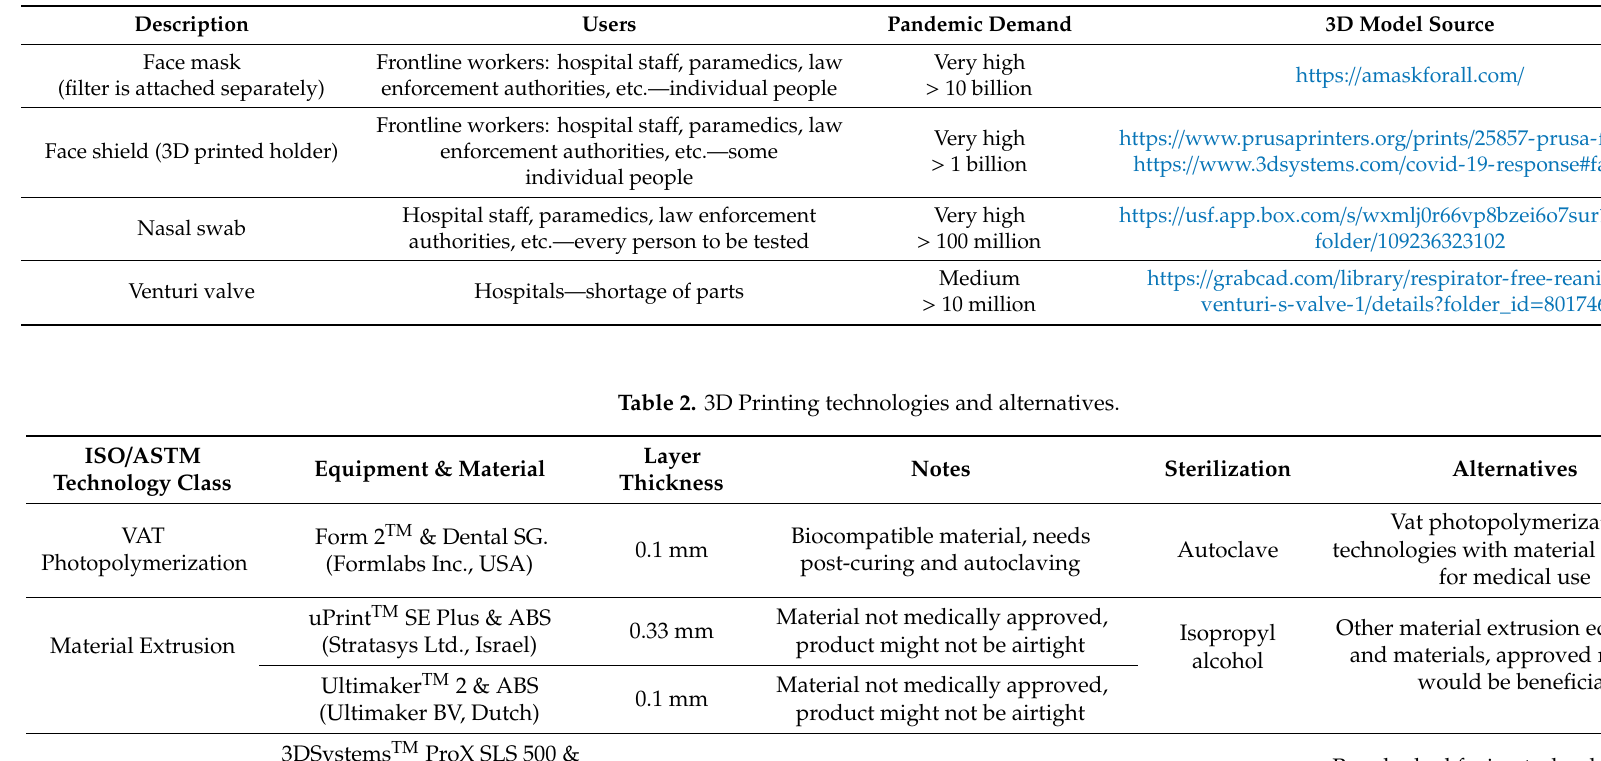
Table 1. Products currently being manufactured using 3D printing in the COVID-19 pandemic.